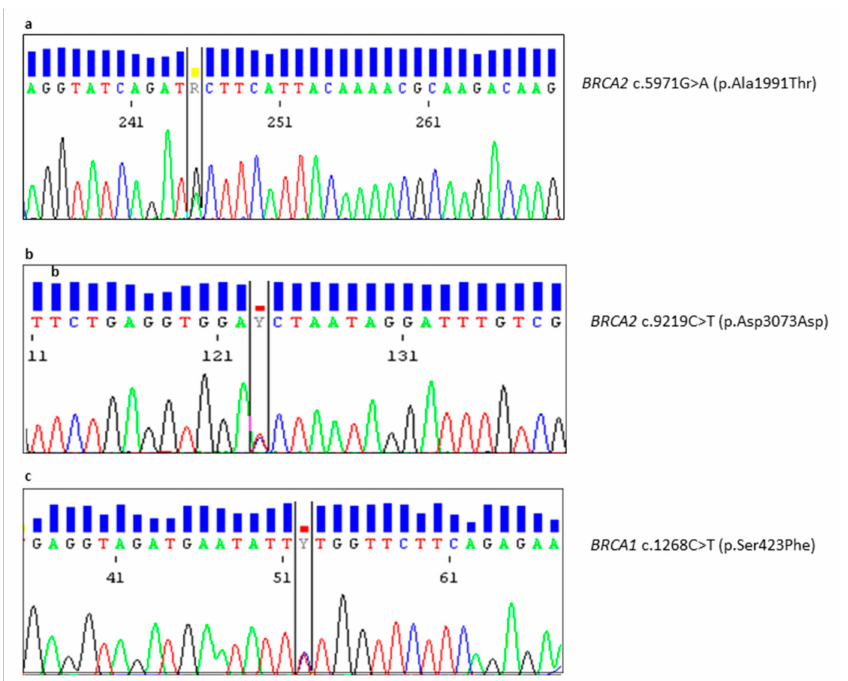
Figure 5. Electropherograms showing novel variants in BRCA1 and BRCA2 genes. ( a ) Sequence of the BRCA2 c.5971G > A variant causing the p.(Ala1991Thr) substitution within exon 11. ( b ) Sequence of the BRCA2 c.9219C > T; p.(Asp3073Asp) synonymous variant in exon 24. ( c ) Sequence of the BRCA1